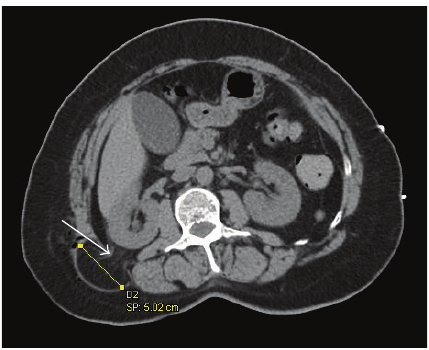
Figure 1: Noncontrast CT of patient’s abdomen showing a right sided Grynfeltt-Lesshaft hernia. Arrow: adipose tissue herniating through defect at the upper lumbar triangle. Line with square endpoints: hernia sac diameter measurement.